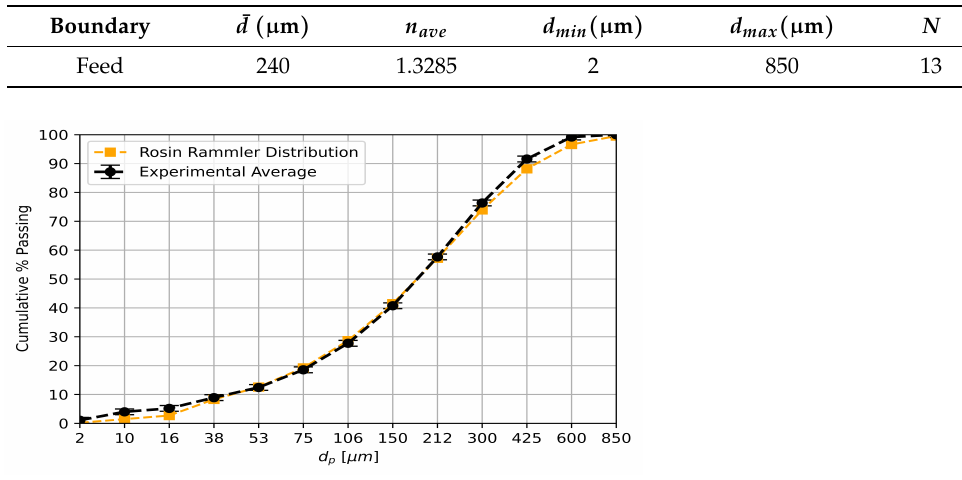
Figure 4. Feed PSD—experimental average against the Rosin–Rammler distribution